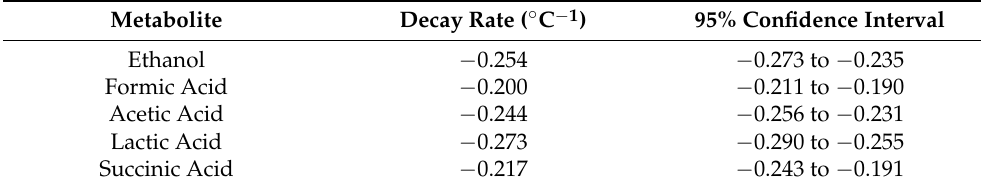
Table 3. Decay rate parameter with a 95% confidence interval from the exponential function of threshold time by storage